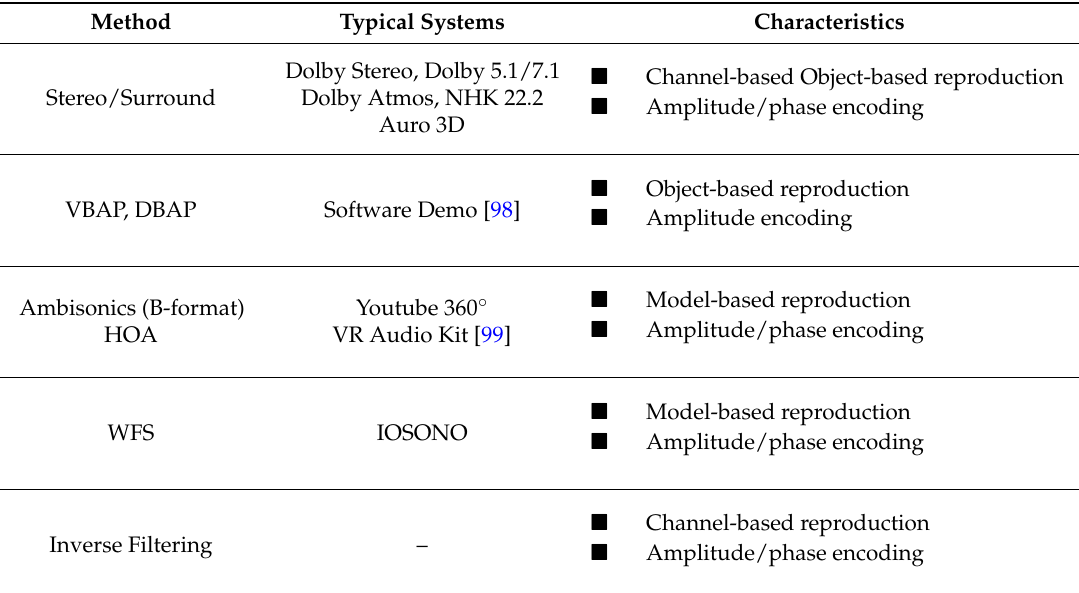
Table 1. Summary of soundfield reproduction methods and commercial